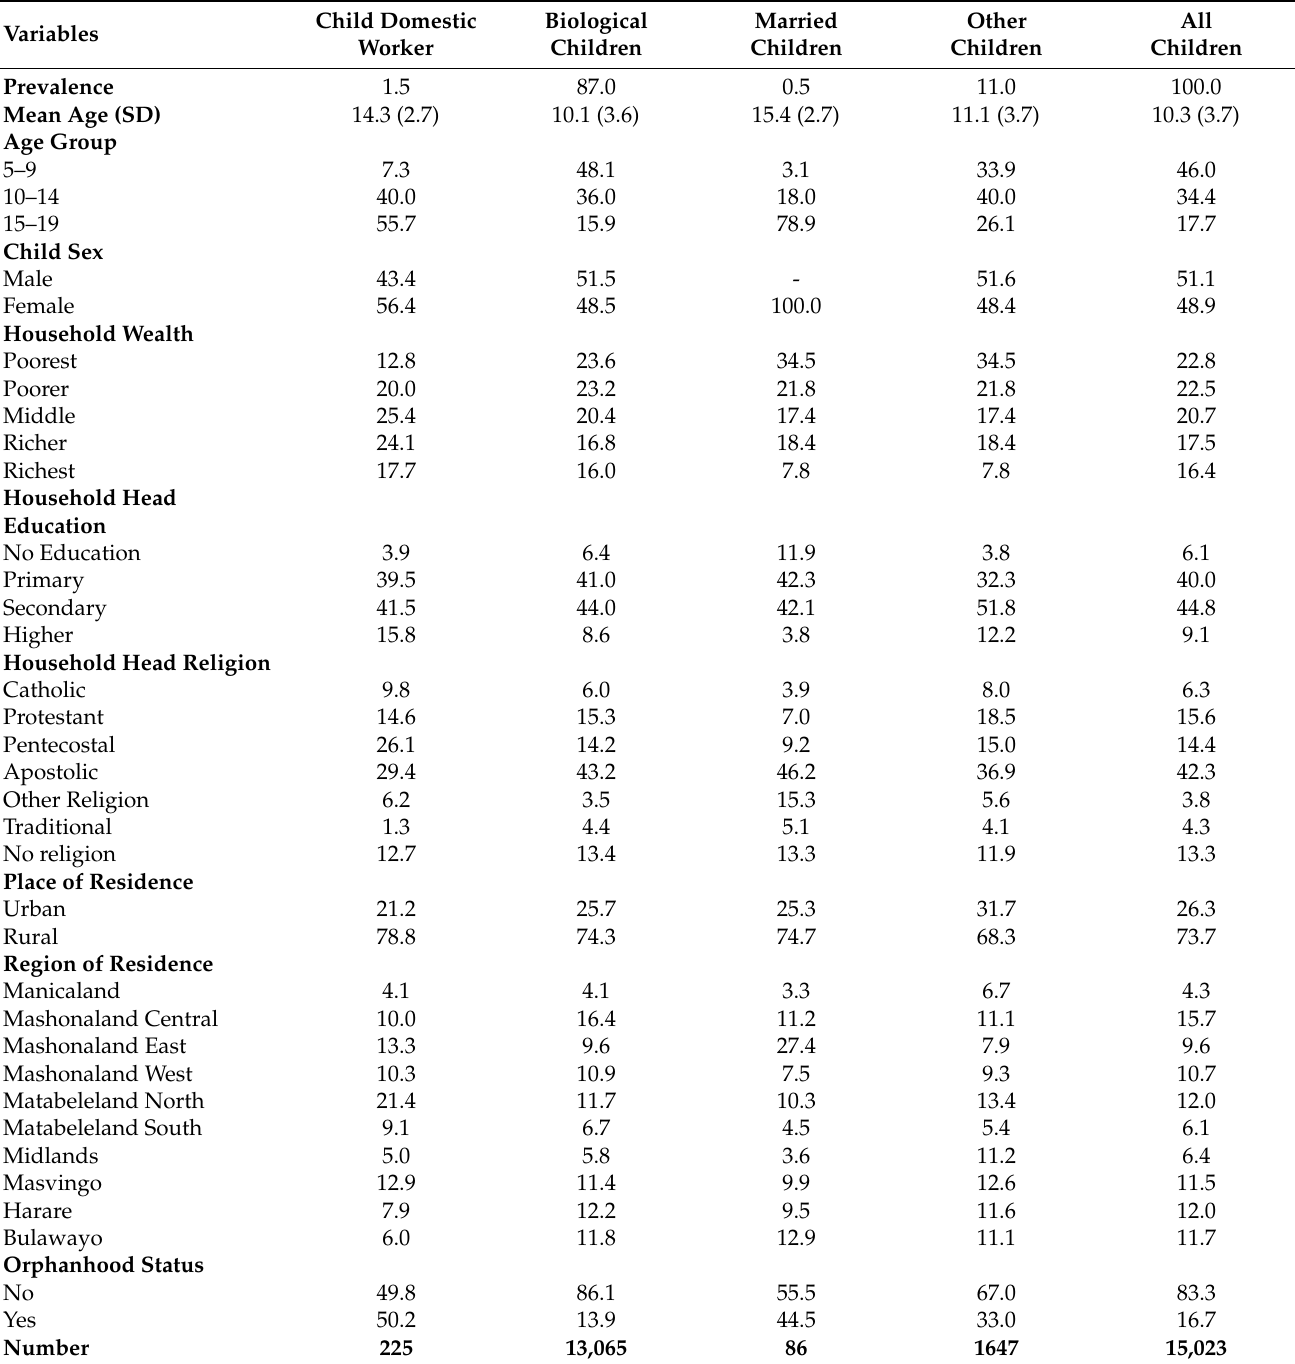
Table 1. Characteristics of Child Domestic Workers, Biological children, Married children, and other children in households in Zimbabwe, 2019 ( N = 15,023,